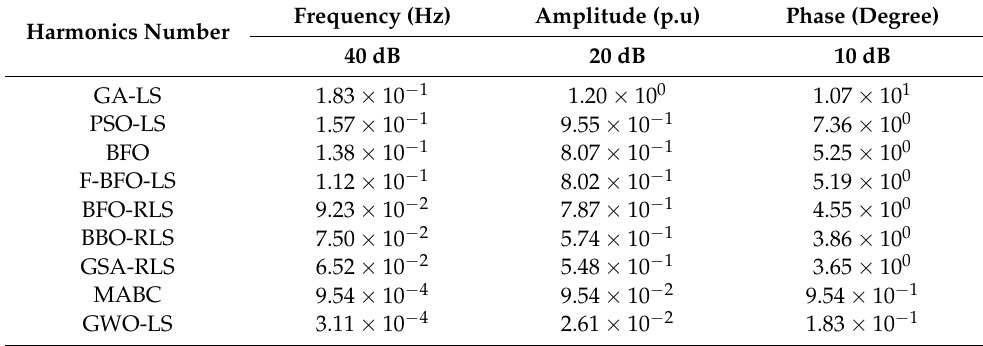
Table 8. PER comparison of GWO-LS with Literature harmonics estimator for Noisy